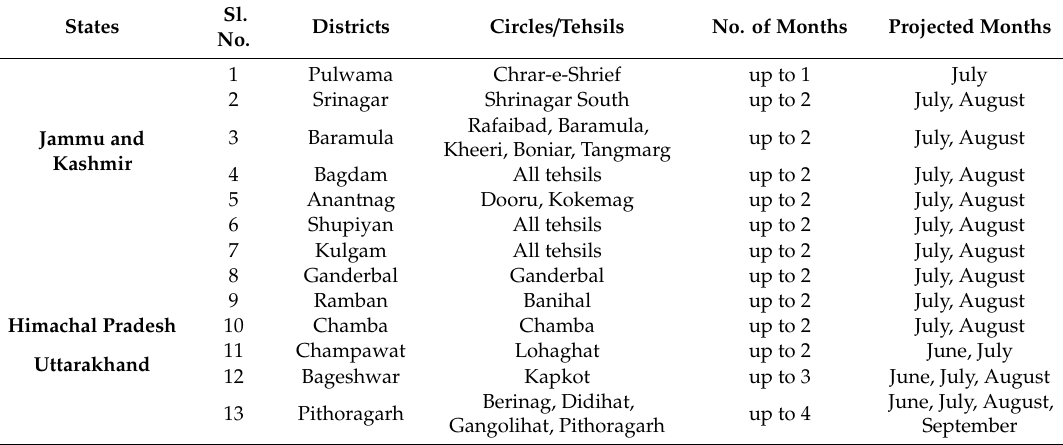
Figure 6. Projected changes in a number of months in the Transmission Window (TW) for malaria ( Pv and Pf ) transmission by the 2030s as compared to baseline years. New foci of malaria transmission in the states of Jammu & Kashmir, Uttarakhand and Himachal Pradesh particularly for P vivax , while a reduction in parts of Orissa and Gujarat are visible. Increase in the transmission of P. falciparum by one month in the central part of India is discernible. Table 2. Districts having projected new foci for P vivax malaria transmission (TWs in months). (Refer Figure S2).